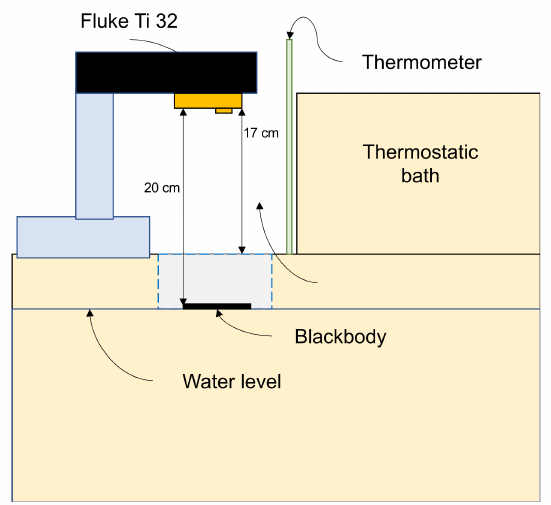
Figure 2. Thermal calibration